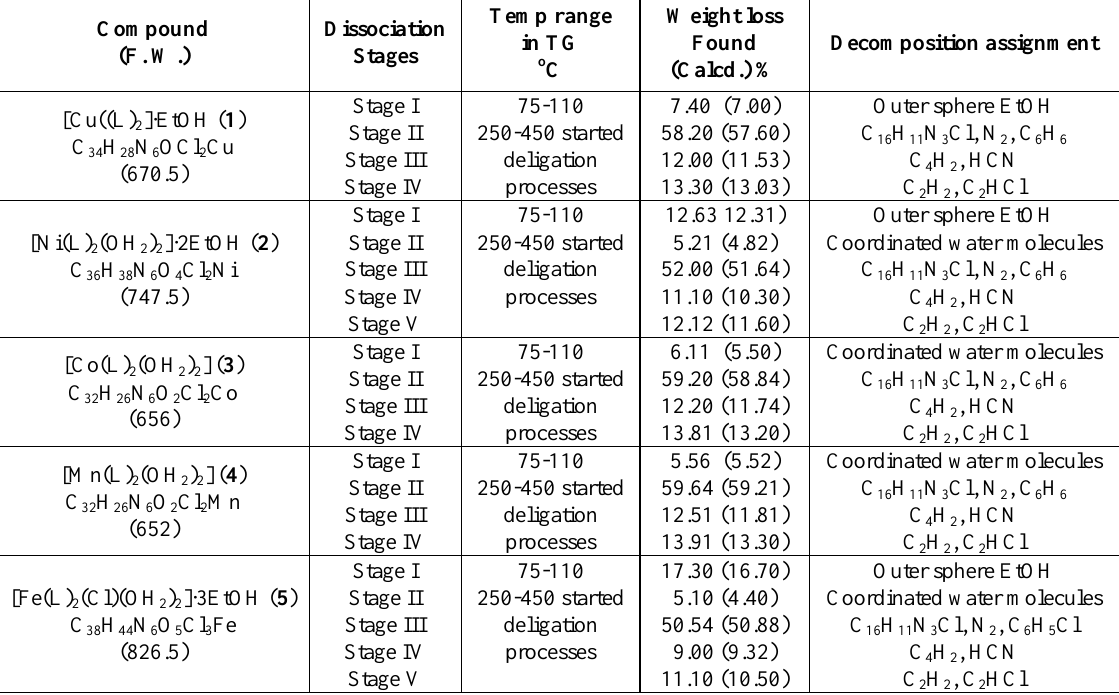
Table 5. Thermal analyses data for some metal complexes of HL